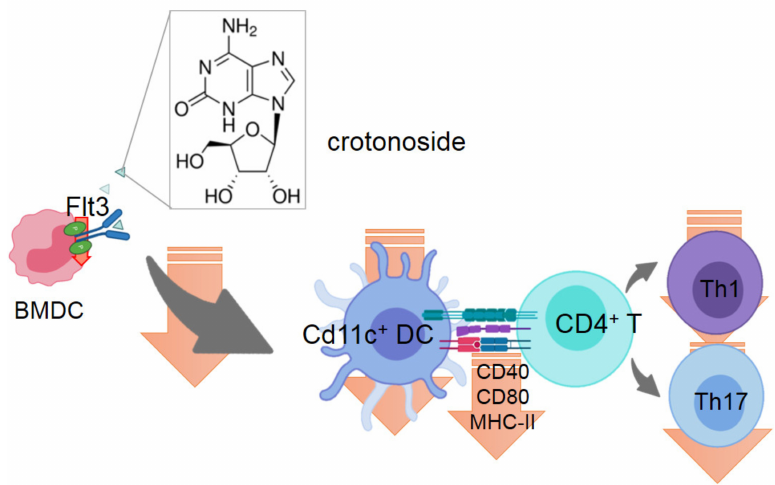
Figure 9. Proposed model of mechanisms exploited by crotonoside to alleviate the CIA in the mouse model. Upon administration of crotonoside, the DC maturation and differentiation were reduced and the capability of priming T cells due to lower CD40, CD80, and MHC-II expressions. Subsequently, the T cell di ff erentiation into pathological Th1 and Th17 were